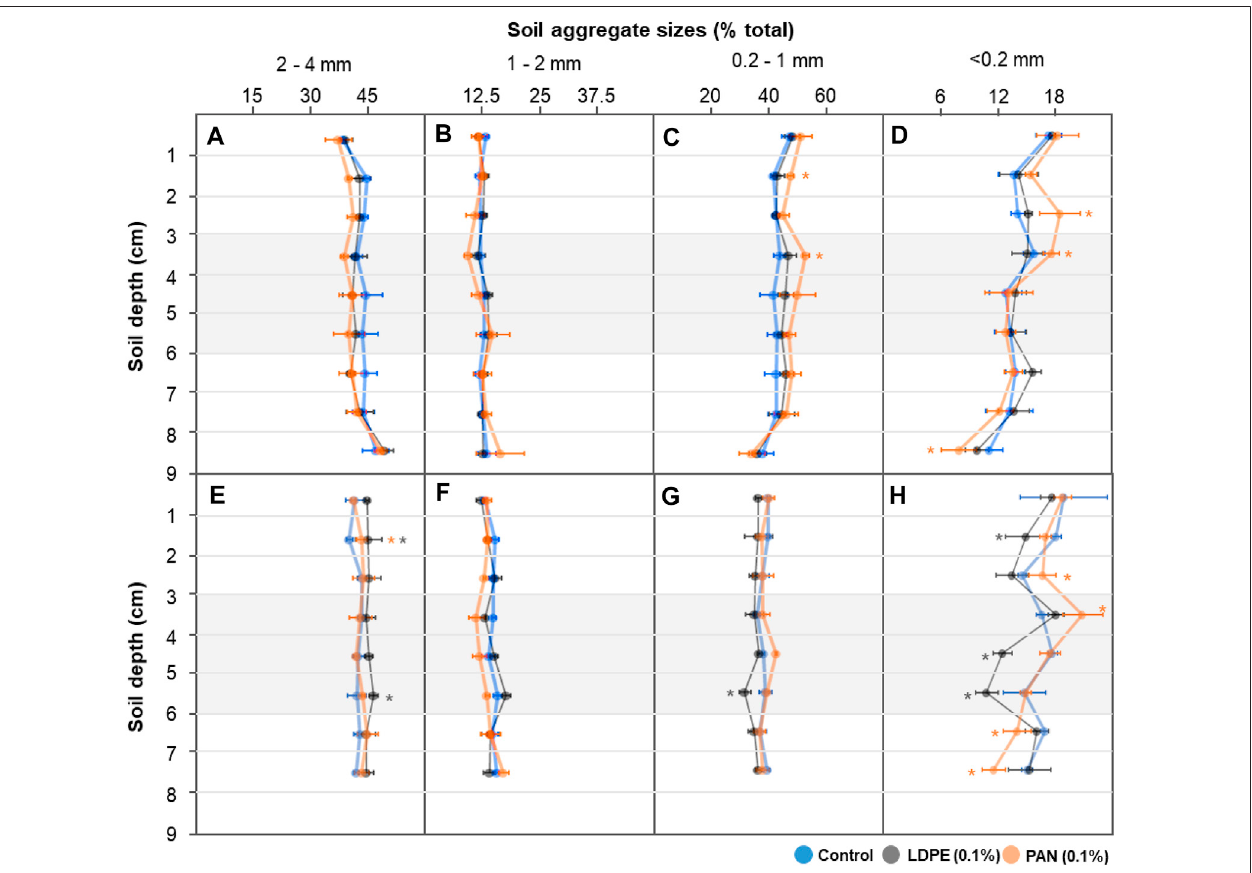
FIGURE 5| The fractions of each soil aggregate size (2 – 4; 1 – 2; 0.2 – 1; < 0.2 mm) in each depth (0 – 9 cm) after high-level irrigation. Each soil column was incubated for 1 day (A – D) and 60 days (E – H) . Asterisk represents signi fi cance at the level of 5% ( p (cid:2) 0.05) between control and microplastic-containing soil layer